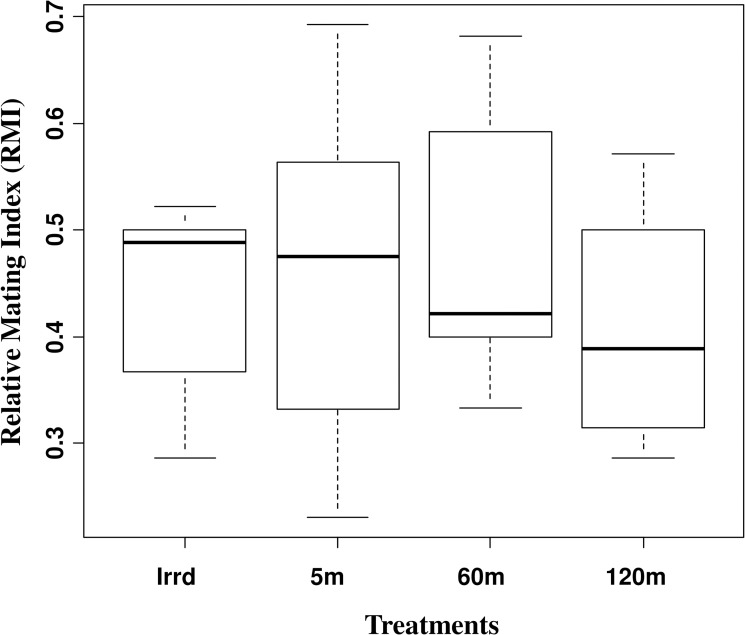
Impact of the release process through the BSITM on male relative mating index (RMI).Seven-day old males from different treatment (only irradiated (Irrd) and irradiated males exposed to the release process for different durations (5, 60 and 120 minutes)) were released in field cage to compete with untreated colony males for mating with three-day old females for two hours. Couples were collected and mating competitiveness was calculated. Thirty flies from each group were used. The graph represents the minimum, first quartile, median, third quartile and maximum for each treatment.